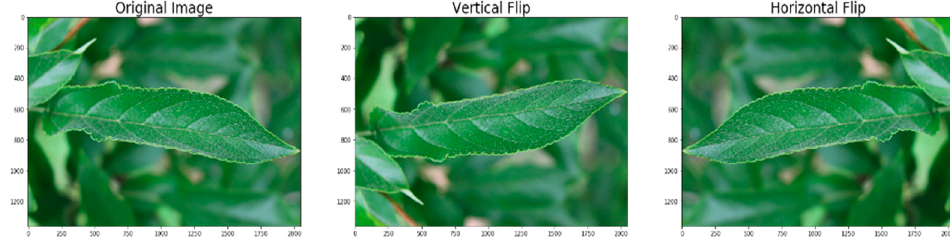
Figure 12. Output of Flipping.